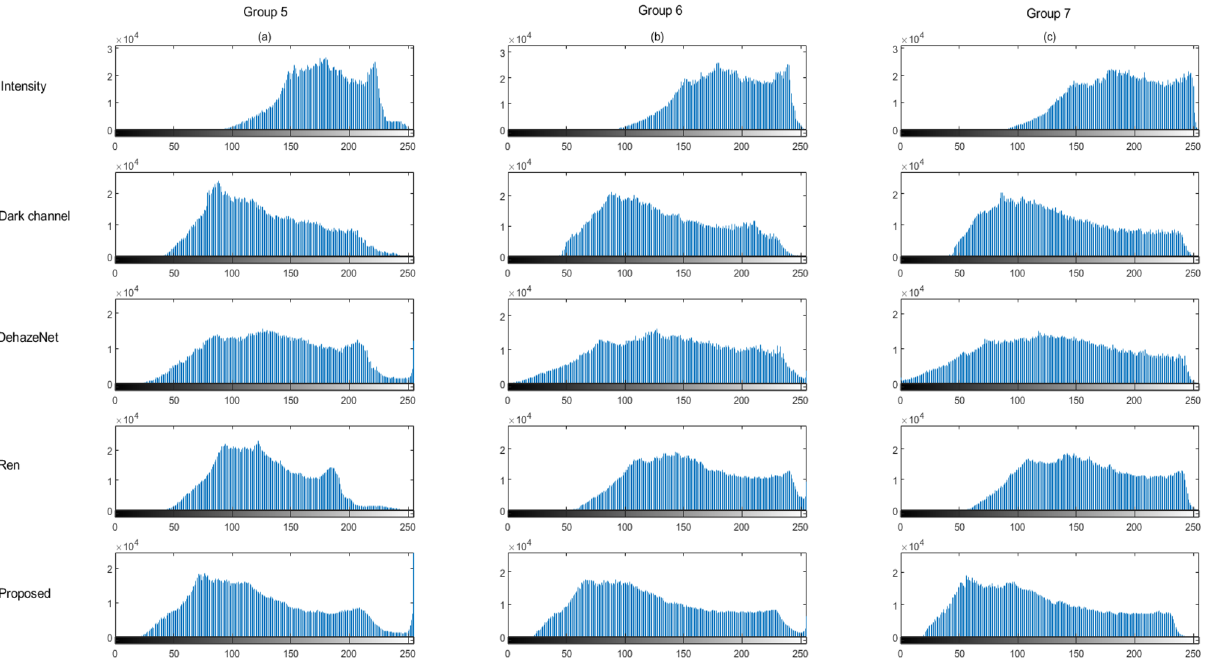
Figure 7. x-axis is frequency, y-axis is gray level. ( a ), ( b ) and ( c ) are the histograms of images in Group 5–7 in Fig. 4, respectively. The intensity images and the corresponding restored images are listed indifferent lines.